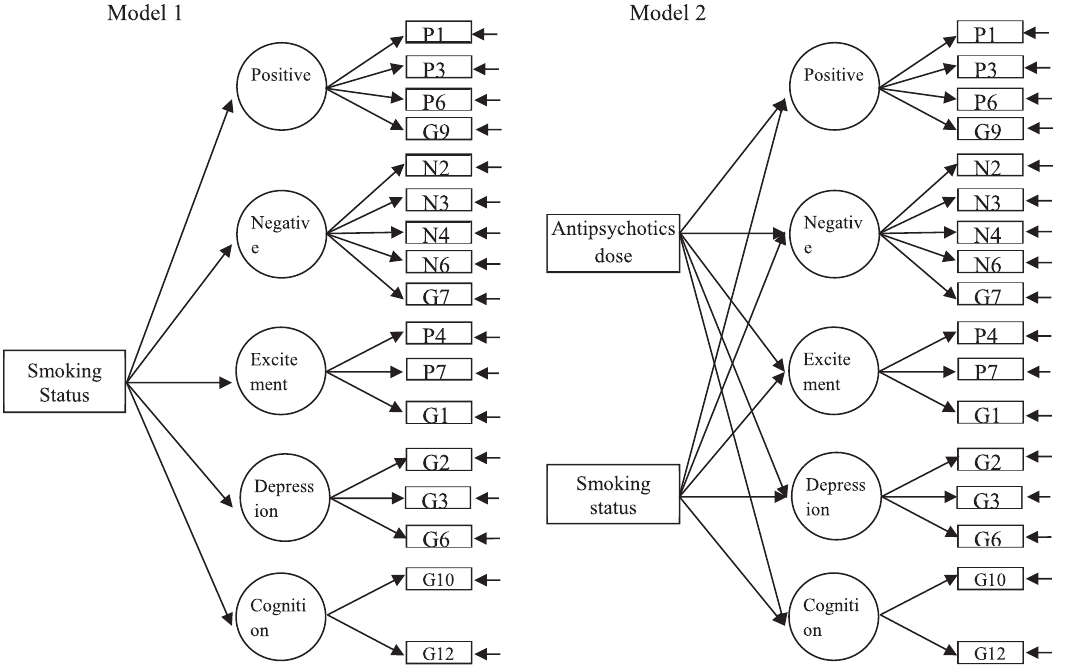
Figure 1. MIMIC model in assessing the effects of current smoking status on symptomatology of schizophrenia.